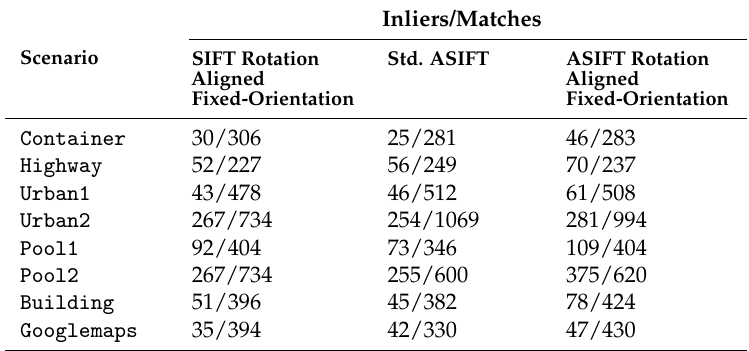
Table 5. Comparison with ASIFT. Inliers and matches for pre-aligned images using standard SIFT with fixed orientation, ASIFT and pre-aligned images on ASIFT with fixed